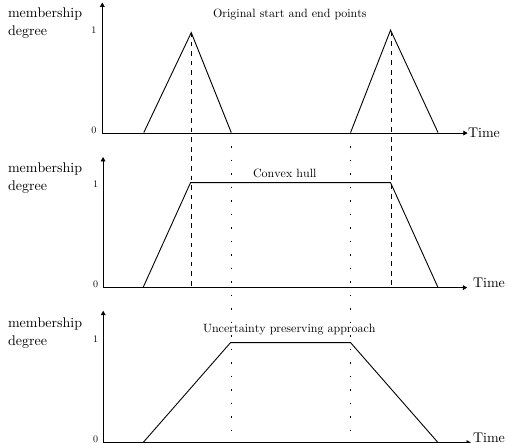
Fig. 3. Transformation to obtain the FVP. The top graph shows the two triangular possibility distributions. The mid- dle graph shows the convex hull validity period, the bottom one shows the result of the second transformation, which maintains the